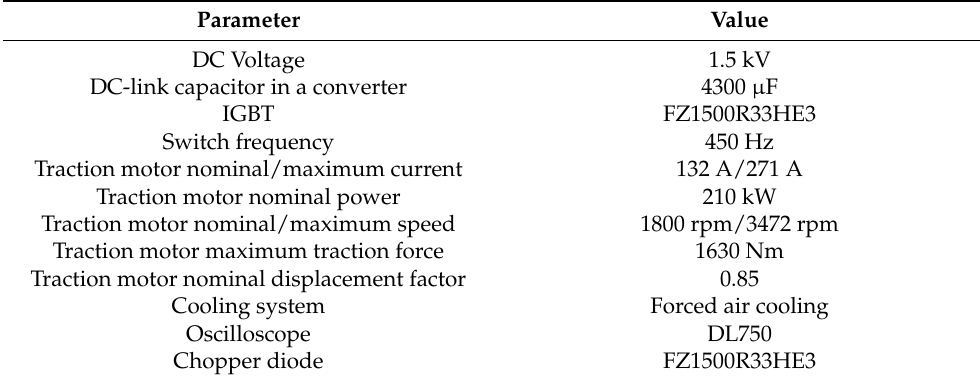
Figure 22. Traction converter 3D structure.